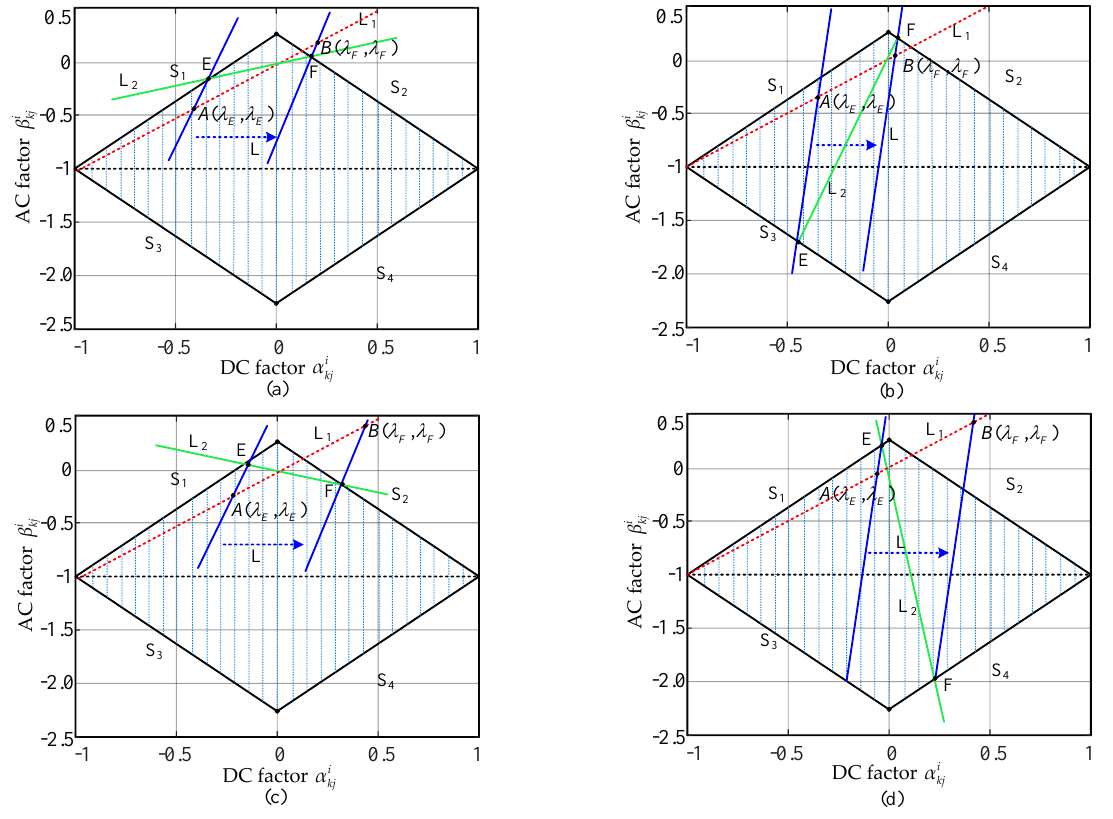
Figure 4 . Choosing appropriate DC and AC factor for maximum tolerance in different conditions: ( a ) when 0 < η kj ≤ 1; ( b ) when n ( c ) when − 1 < η kj ≤ 0; ( d ) when η kj ≤ −